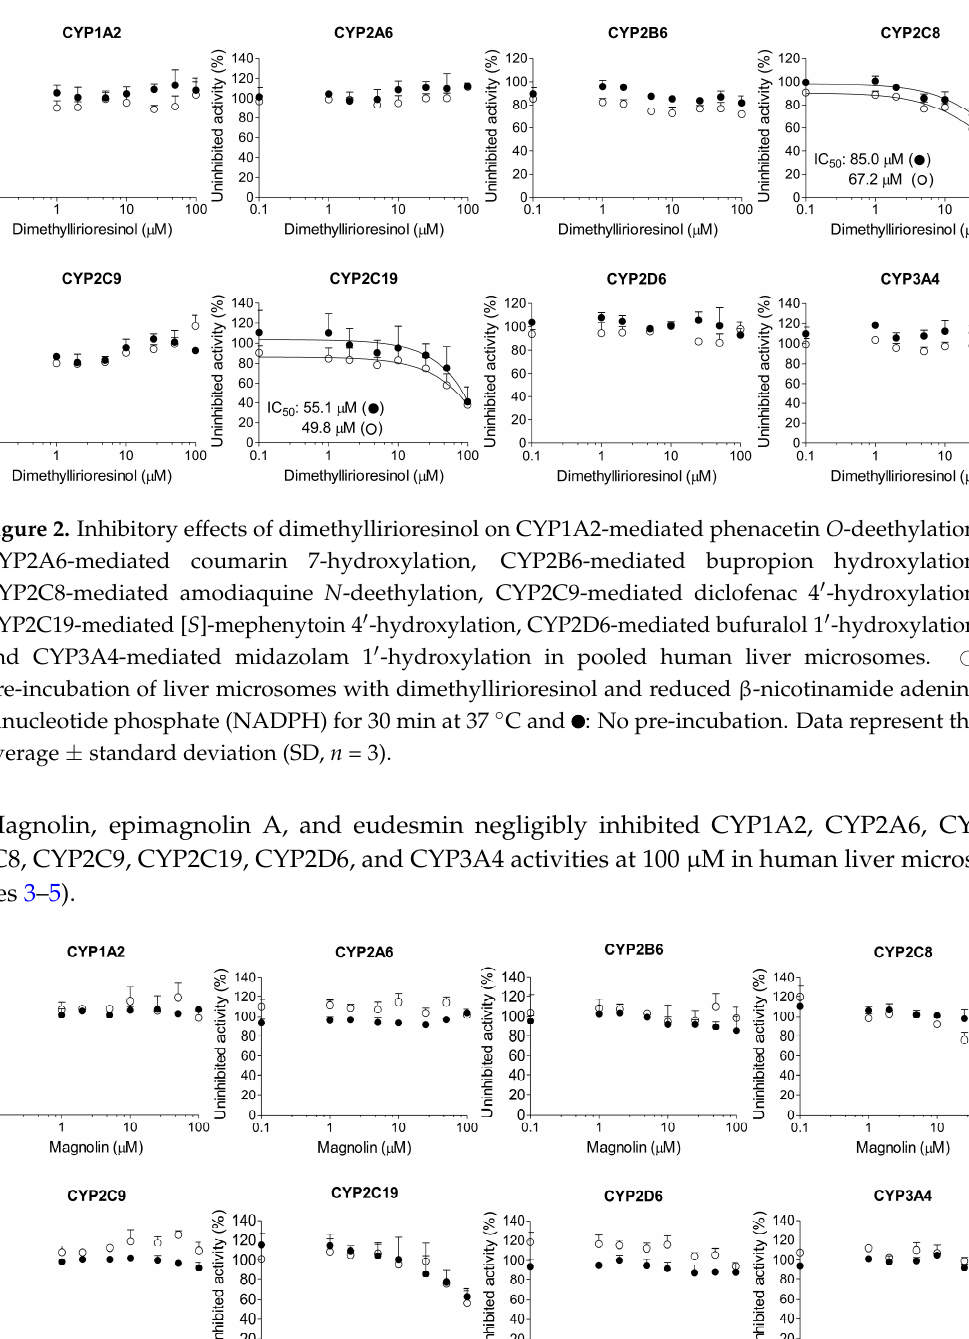
Figure 3. Inhibitory effects of magnolin on CYP1A2-mediated phenacetin O -deethylation, CYP2A6-mediated coumarin 7-hydroxylation, CYP2B6-mediated bupropion hydroxylation, CYP2C8-mediated amodiaquine N -deethylation, CYP2C9-mediated diclofenac 4’-hydroxylation, CYP2C19-mediated [ S ]-mephenytoin 4’-hydroxylation, CYP2D6-mediated bufuralol 1’-hydroxylation, and CYP3A4-mediated midazolam 1’-hydroxylation in pooled human liver microsomes. : Pre-incubation of liver microsomes with magnolin and NADPH for 30 min at 37 °C, : No pre-incubation. Data represent the average ± SD ( n = 3).